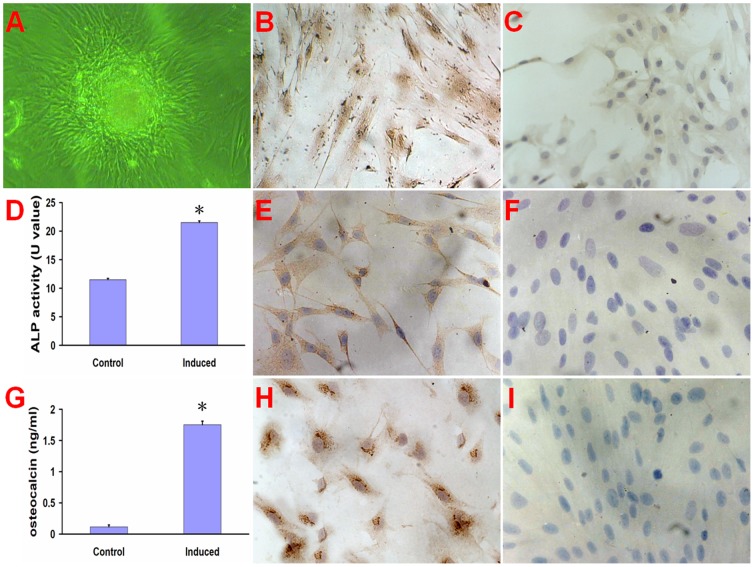
The culture and characterization of hMSCs.The hMSCs formed calcium nodus after 12 day culture (A). The hMSCs (200×) stained immunohistochemically positive for ALP (B), osteocalcin (E) and collagen type I (H) compared to non-induced cells (C, F, and I). The ALP activity (D) of hMSCs and osteocalcin concentration (G) in the culture medium were significant higher in induced group than that in control group (non-induced cells). *p < 0. 01, compared with control group.